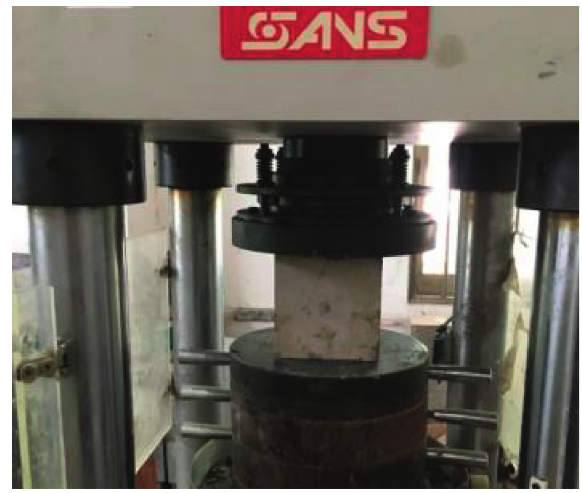
Figure 2: Loading